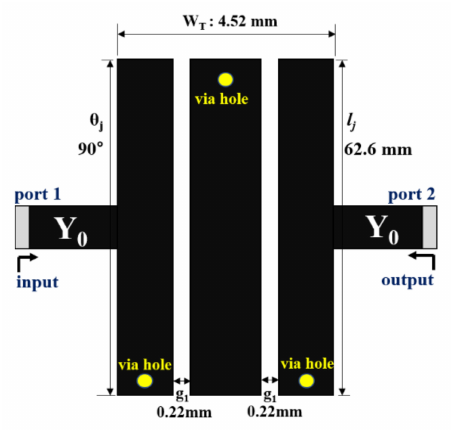
Figure 1. Conventional interdigital BPF